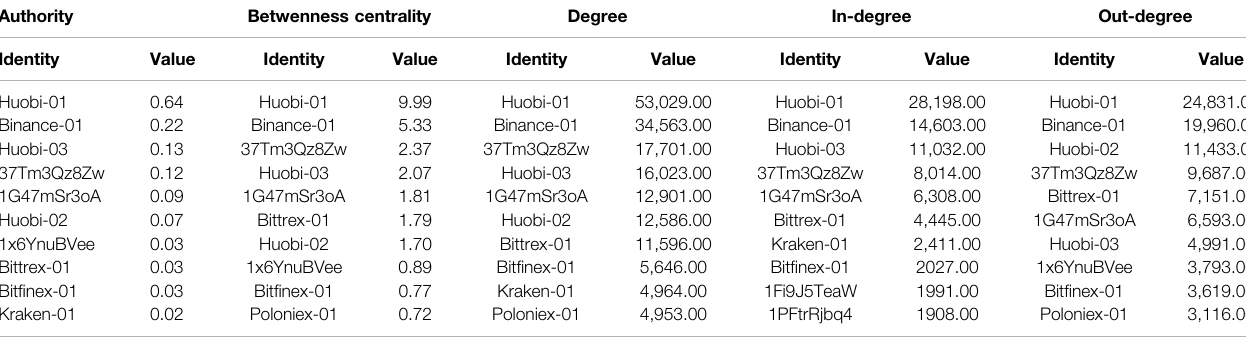
TABLE 3 | Top 10 central nodes according to Authority, Betwenness Centrality score, In-degree, Out-degree and Degree.